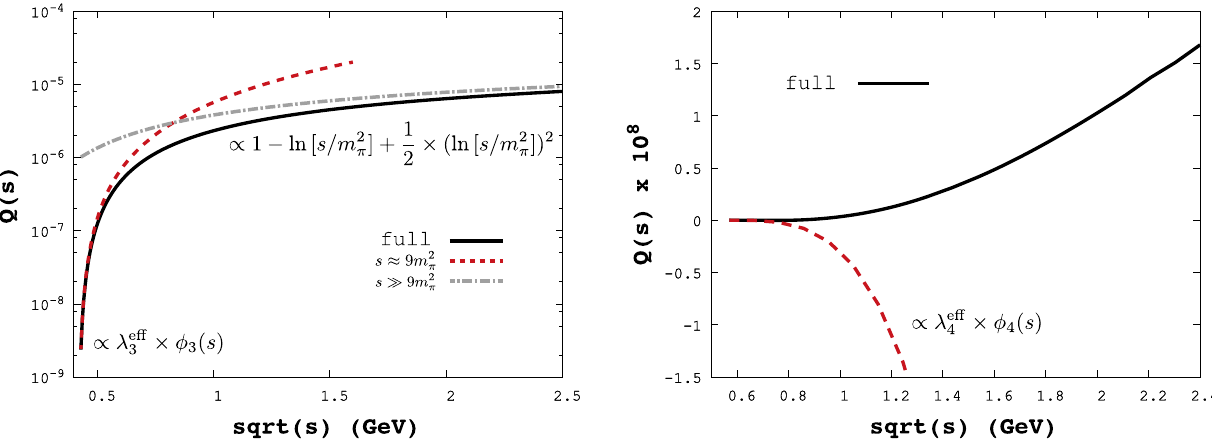
Fig. 4 The generalized phase space function Q ( s ) for triangle ( left ) and box ( right ) diagrams under an on-shell condition discussed in the